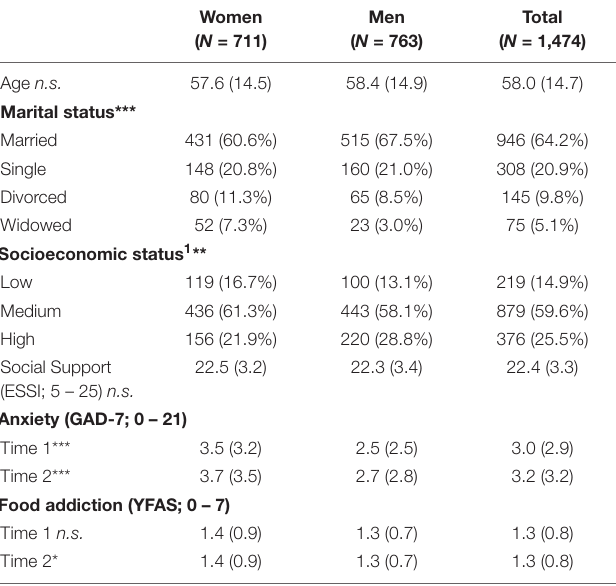
TABLE 1 | General characteristics of the study population.